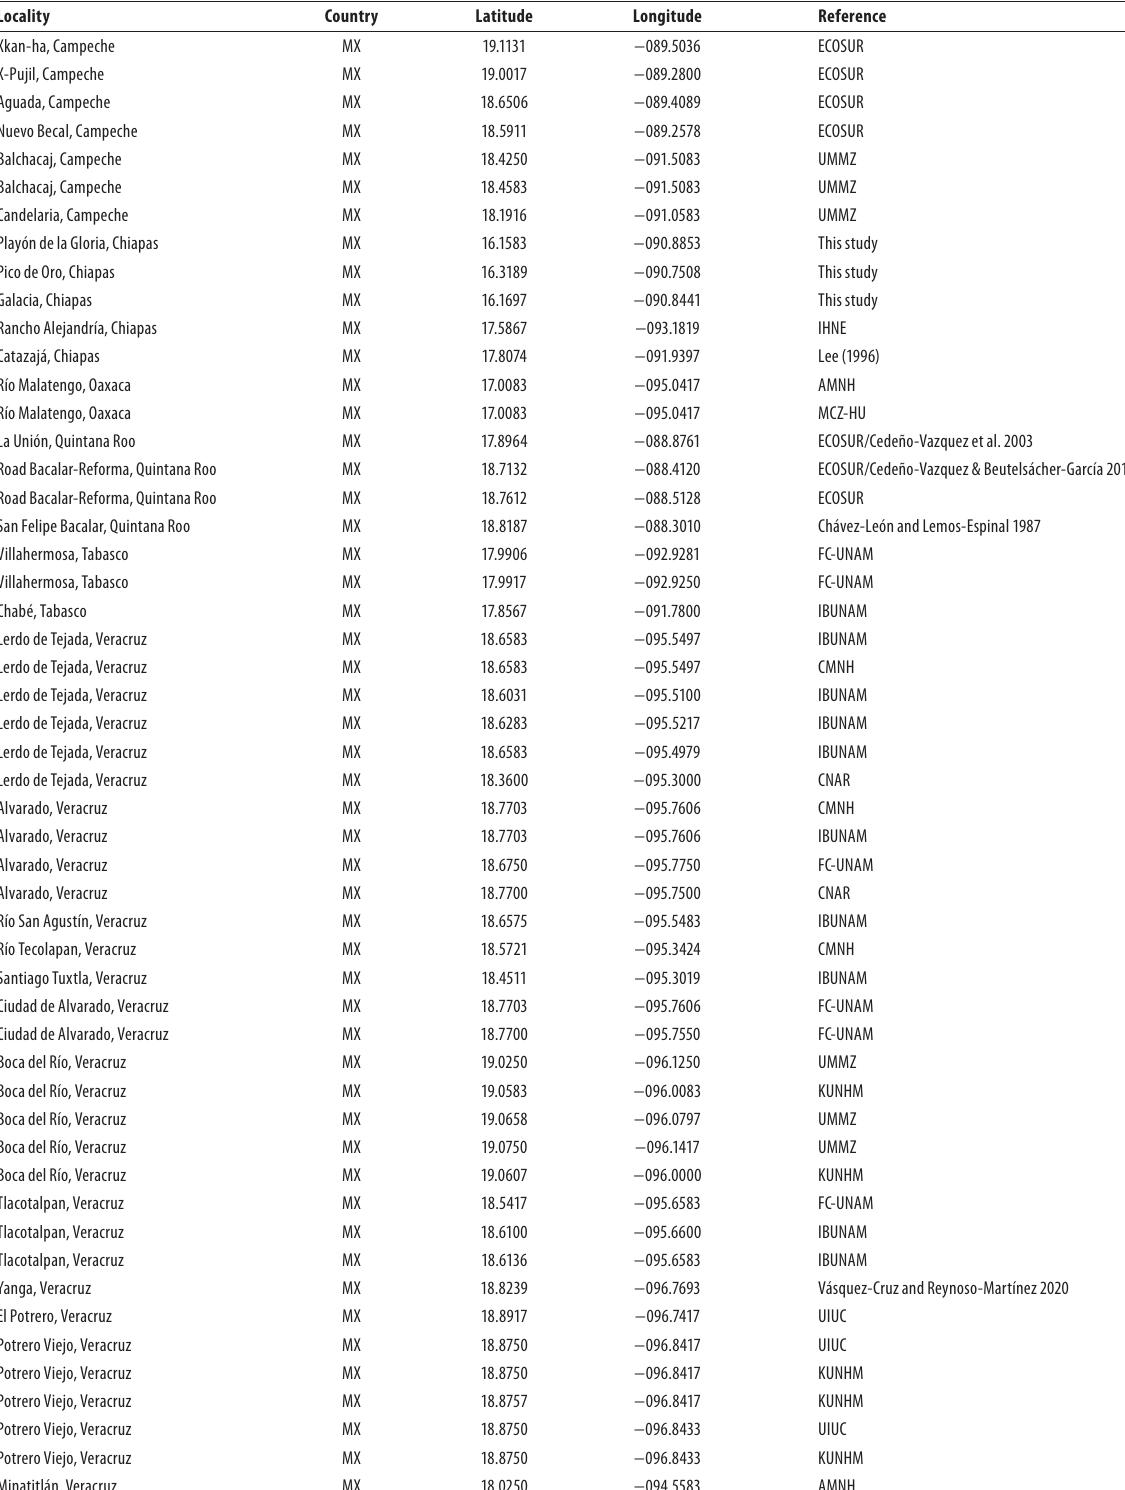
Table A1. Locality records of Claudius angustatus from Mexico and Central America, derived from literature records, official institutions and from the present study. Only specimens including coordinates and localities from reliable sources are shown. Abbreviations: MX = Mexico; BZ = Belize; GT = Guatemala. Institutional abbreviations: Ecosur = El Colegio de la Frontera Sur; UMMZ = University of